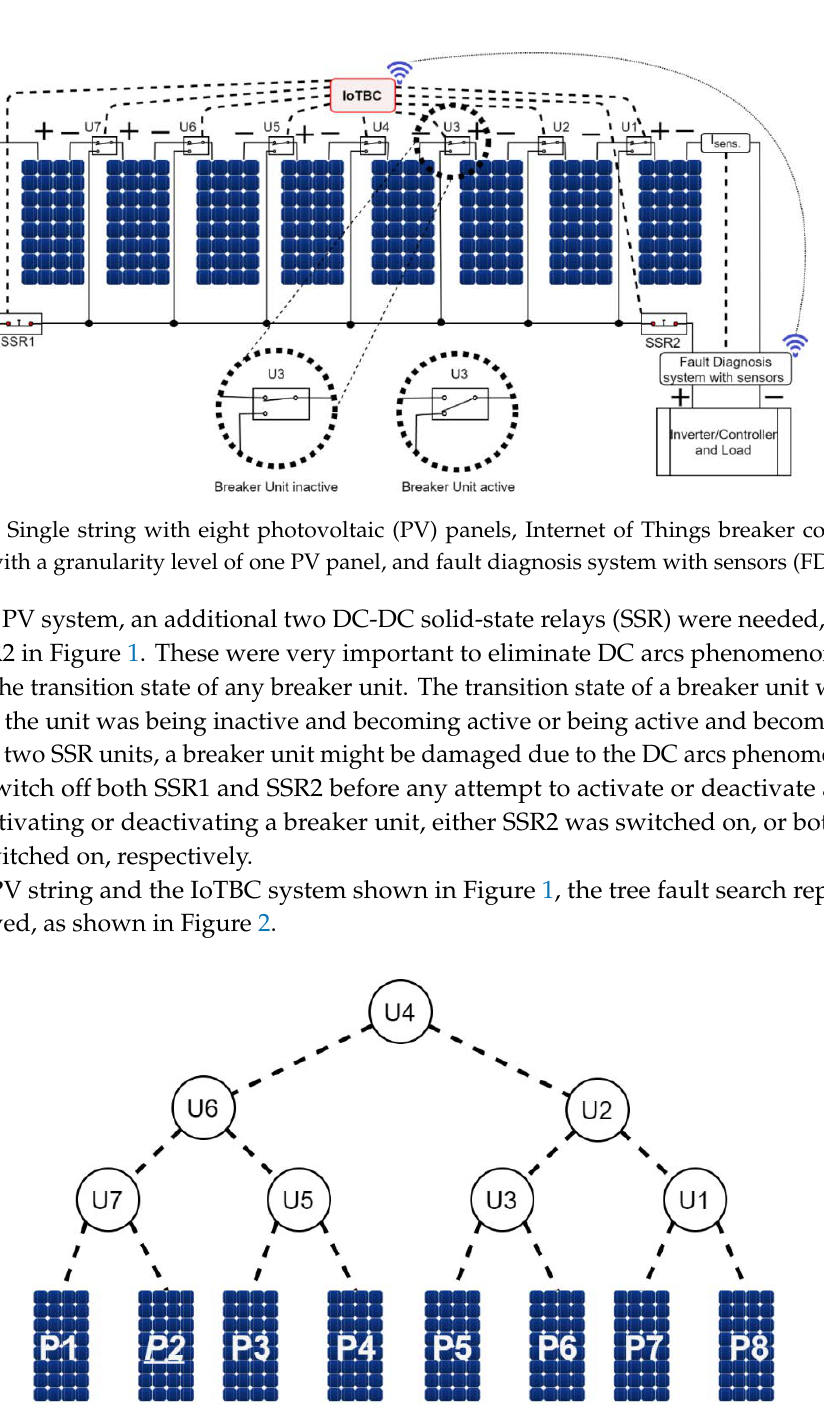
Figure 2. Tree search representation of the PV string in Figure 1.